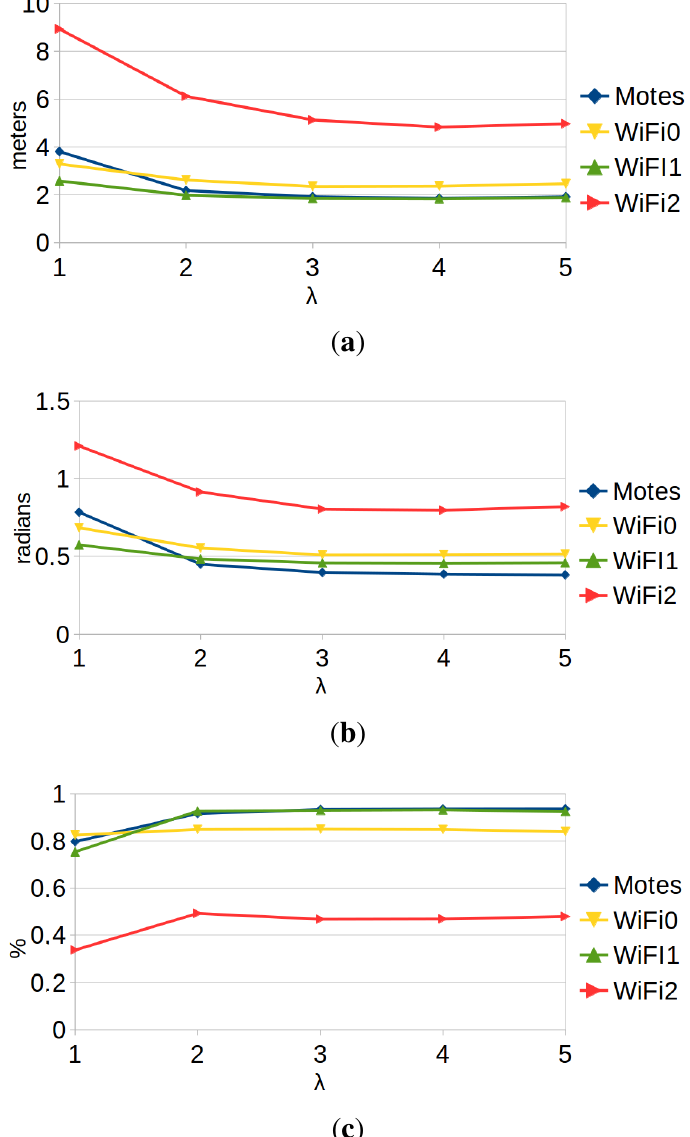
Figure 9. Comparison of the performance of the algorithm using the motes (blue) and each WiFi card (yellow, green, red). ( a ) e